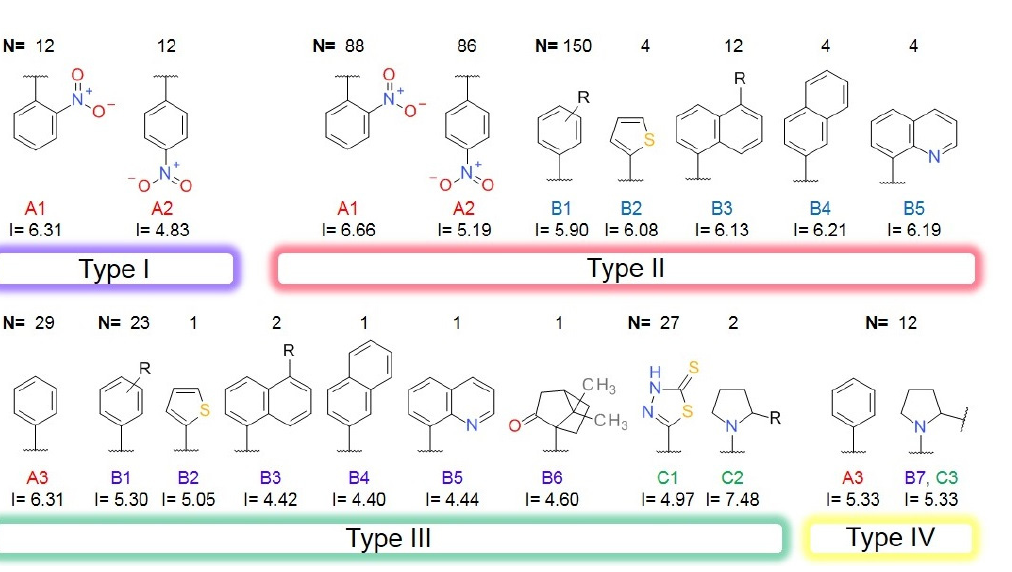
Figure 3. The plain rings (PR) as elements of each architectural type of BC inhibitor, together with their impact score (I) and number of occurrences (N) in the BCI set.